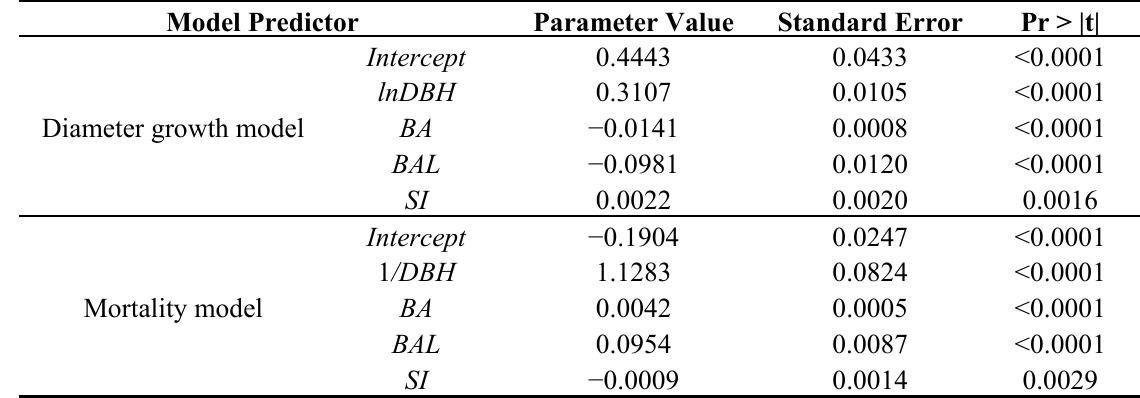
Table 6. The parameter estimates from SUR of ( Δ d +1) and P i in the system of equations for Mongolia oak ( n =